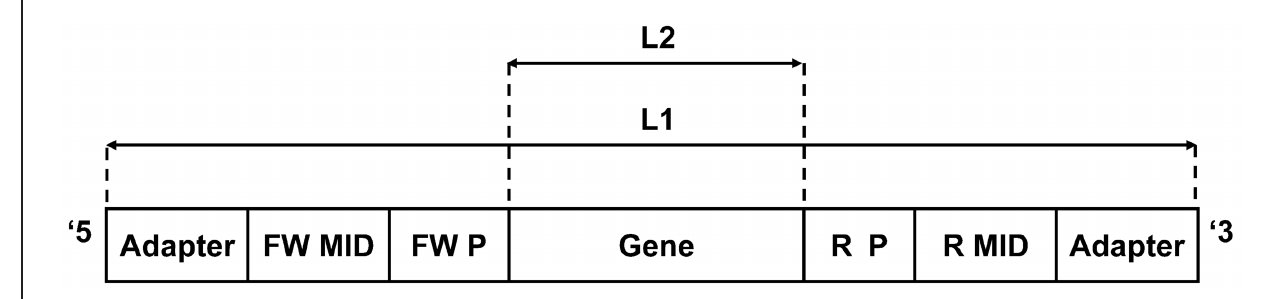
FIGURE 1 | A typical sequencer output (e.g., 454) read consists of the following segments (ordered from the 5 (cid:2) end to the 3 (cid:2) end): adapter: sequencer adapters. FW MID denotes the forward molecular identifier (tag). FW P denotes the forward polymerase chain reaction (PCR) primer. Gene is the target sequence. R P denotes the reverse PCR primer. R MID denotes the reverse molecular identifier